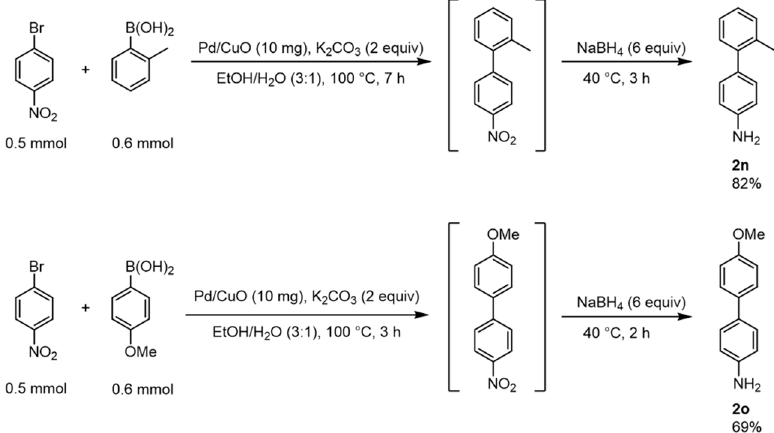
Figure 2. One-pot Suzuki–Miyaura cross-coupling and nitro group reduction catalyzed by Pd/CuO.